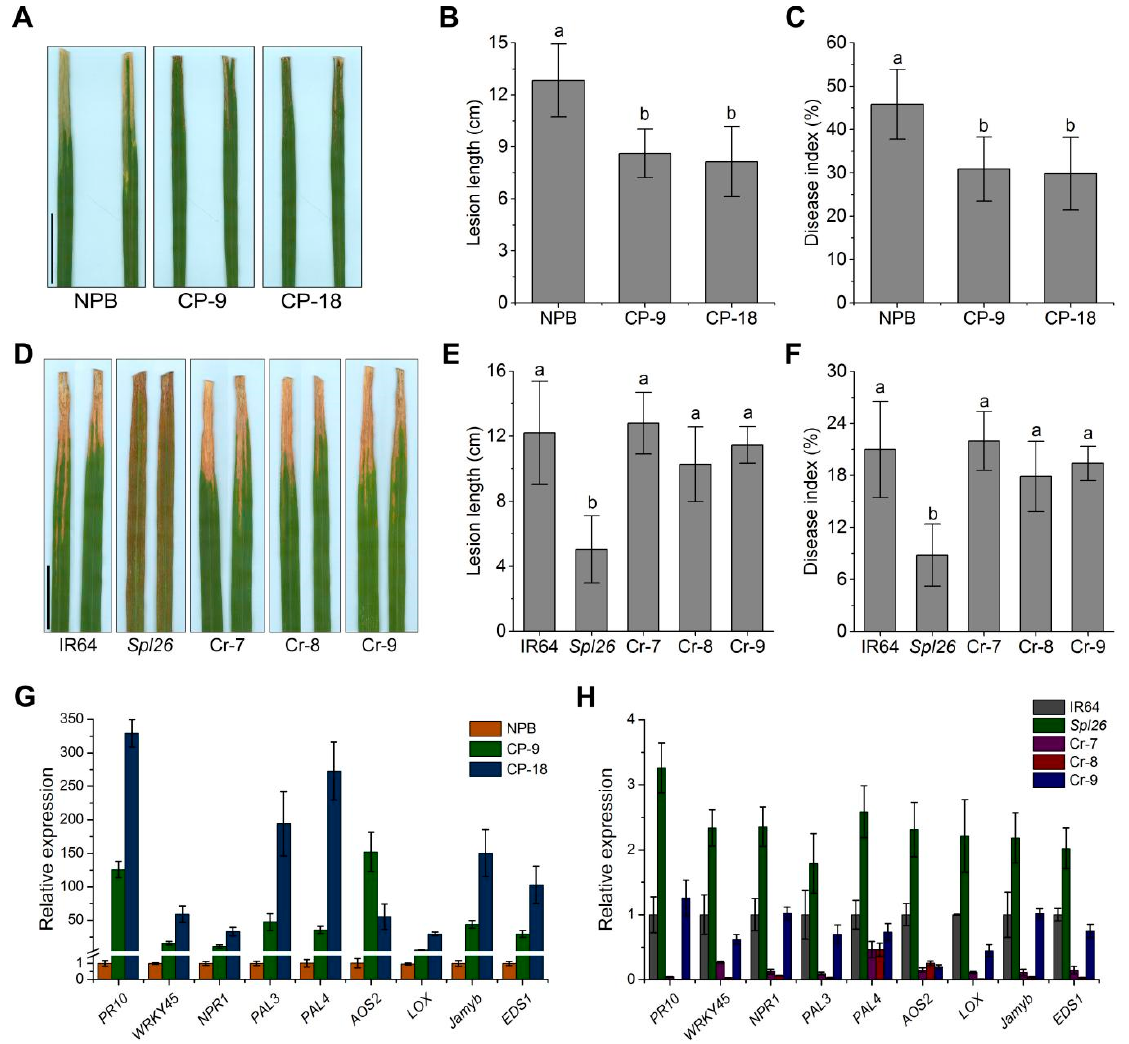
Figure 6. Disease evaluation and relative expression of defense response genes. ( A , D ) Responses of NPB, IR64, Spl26 , and transgenic lines to race PXO99 at the tillering stage. Bars = 5 cm; ( B , E ) Lesion length; ( C , F ) Disease index. Data are means ± SD ( n = 6), and different letters indicate significant differences at p < 0.05 by Duncan’s multiple test; ( G , H ) Expression levels of defense response genes in NPB, IR64, Spl26 and transgenic lines. Data are means ± SD ( n = 3).